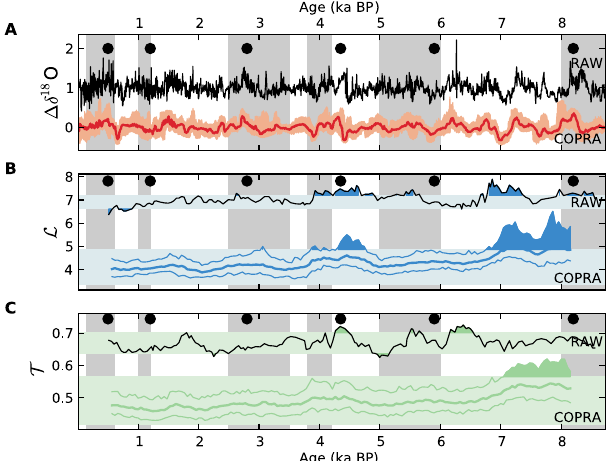
Figure 6. Effects of dating uncertainties on the results of RN anal- ysis for the Dongge DA residual oxygen isotope record (COPRA). Data and results for the original Dongge record (RAW) are also dis- played for reference (data and results have been shifted vertically to larger values for readability, compare Figs. 7 and 8). (a) Resid- ual oxygen isotope ratio after detrending, (b) RN average path length L , and (c) RN transitivity T . Median (thick coloured lines) and 90% confidence intervals (coloured shading and thin coloured lines) from an ensemble of 100 time series realisations of the CO- PRA algorithm for transferring dating uncertainties to uncertain- ties in proxy values and, hence, in RN measures are shown. The values of RN measures expected for the predominant dynamical regime from all COPRA realisations are indicated by the 90% con- fidence bounds from a stationarity test (horizontal coloured bands in panels b and c , cf. Donges et al., 2011a). Epochs of atypical cli- matic variability (regime shifts) are indicated by filled-in dark blue and dark green areas, respectively. Bond events (bullets) and RCC episodes (grey bands) are displayed for